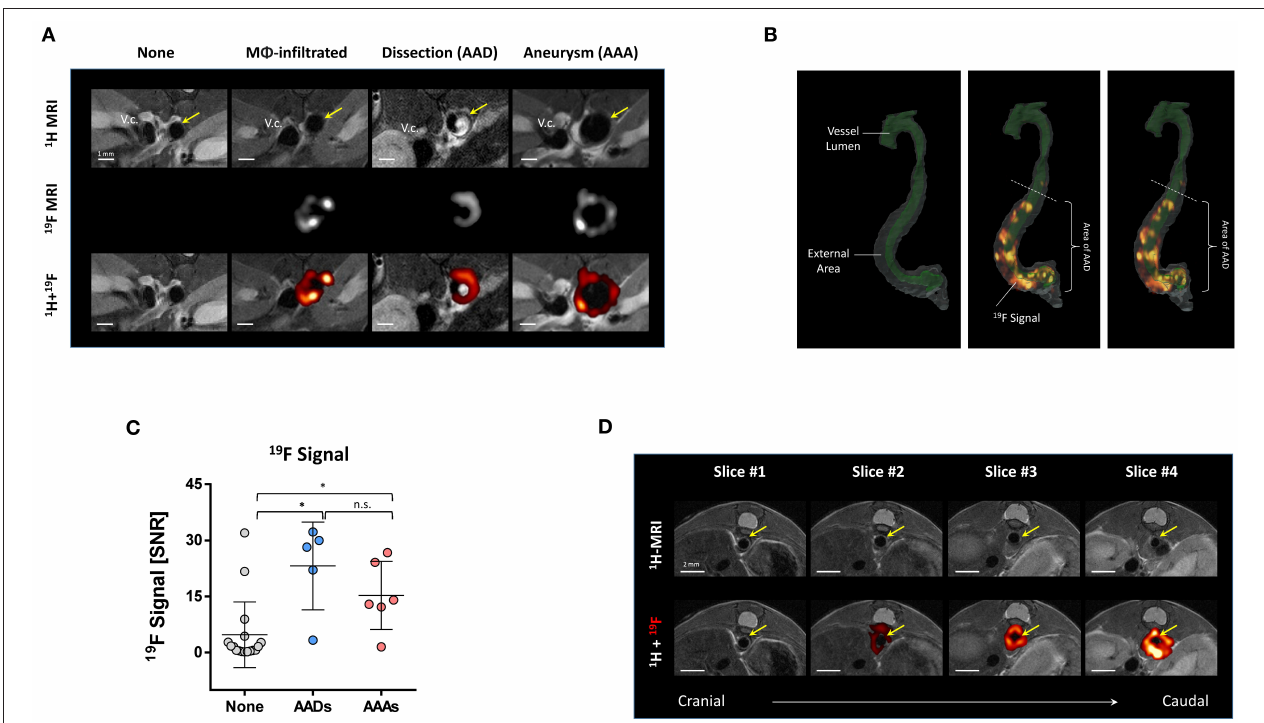
FIGURE 3 | 1 H/ 19 F MR inflammation imaging in AAAs and AADs. (A) For imaging of inflammation, perfluorocarbon nanoemulsions (PFCs) were injected intravenously for in situ labeling of monocytes/macrophages followed by 1 H/ 19 F MRI. Displayed are axial 1 H scans of the abdominal area (upper panel), the anatomically matching 19 F images (middle) as well as a merging of 1 H and the aortic 19 F signal (hot iron scale; lower panel). None, healthy animal without AAA/AAD and no vascular 19 F signal; M Φ -infiltrated, no presence of AAD/AAA despite angII treatment but 19 F signal around the vascular wall; AAD/AAA, abdominal aortic dissections and aneurysms. Arrows indicate the site of the abdominal aorta. (B) 3D reconstruction of a segmented high-resolution ex vivo 1 H/ 19 F MRI scan from an excised and paraformaldehyde fixed aorta with aortic dissection. Gray, external area of the vessel; green, lumen of the vessel; “hot-iron”, 19 F signal. The white dashed line indicates the beginning of the dissection. (C) Quantification of the 19 F signal (mean 19 F signal-to-noise ratio) around the vascular wall. (D) 1 H/ 19 F MRI of an area that is above the location of an aortic dissection. Upper, 1 H MRI; lower, merging of 1 H and 19 F MRI data. 19 F signals of the liver and the spleen were faded out for the sake of clarity. The sequence of the images from left to right is from cranial to caudal. The arrows mark the abdominal aorta (A.a) and the beginning of the aortic dissection can be recognized in the right image as dark structure with an intense 19 F signal. Data are statistically significant with * p ≤